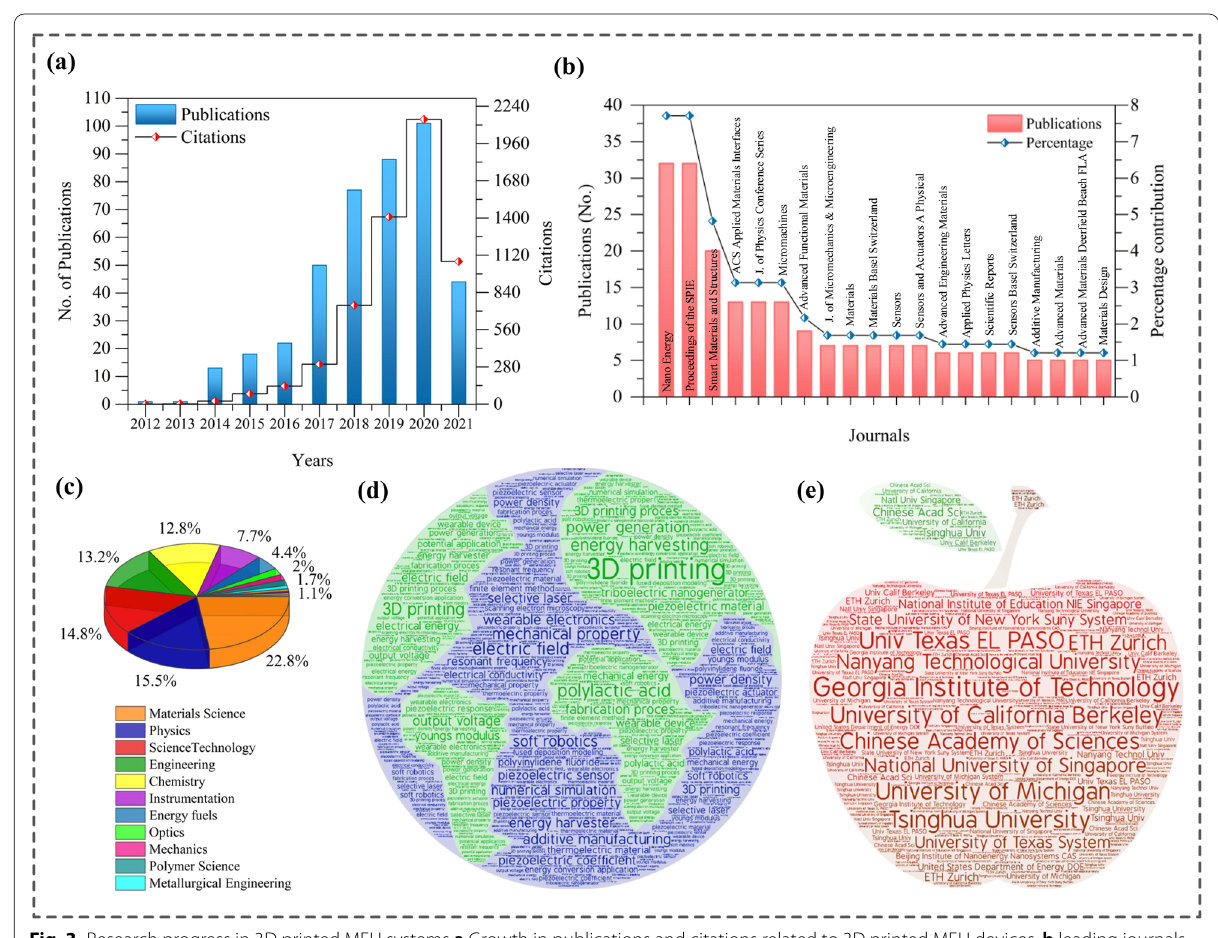
Fig. 3 Research progress in 3D printed MEH systems a Growth in publications and citations related to 3D printed MEH devices, b leading journals in the flourishment of 3DP nano MEH research, c significant research areas of the published literature, d the most influential keywords in the study of 3D-printed nano MEH systems, e the most prolific institutions contributing to the enhancement of nano MEH research, Results were obtained from postprocessing of the data, retrieved from Web of Science using search keywords {TOPIC: ((“3D Printed” OR “3DP” OR “3D printing”)) AND TOPIC: ((“energy convertor” or “Triboelectric” OR “Piezoelectric” OR “Thermoelectric” or “nanogenerator” OR “Nano-energy harvester” OR “Biomechanical energy” OR “human movements” OR “Nano energy” or “Mechanical energy” OR “Energy harvesting” OR “linear generator” OR “Energy harvester” OR “Electromagnetic generator”)), Refined by: Document types: (Article or Review) and Research domains: (Science & Technology) and Languages: (English), Timespan: 2010–2021. Databases: WOS, CSCD, DIIDW, KJD, MEDLINE, RSCI,